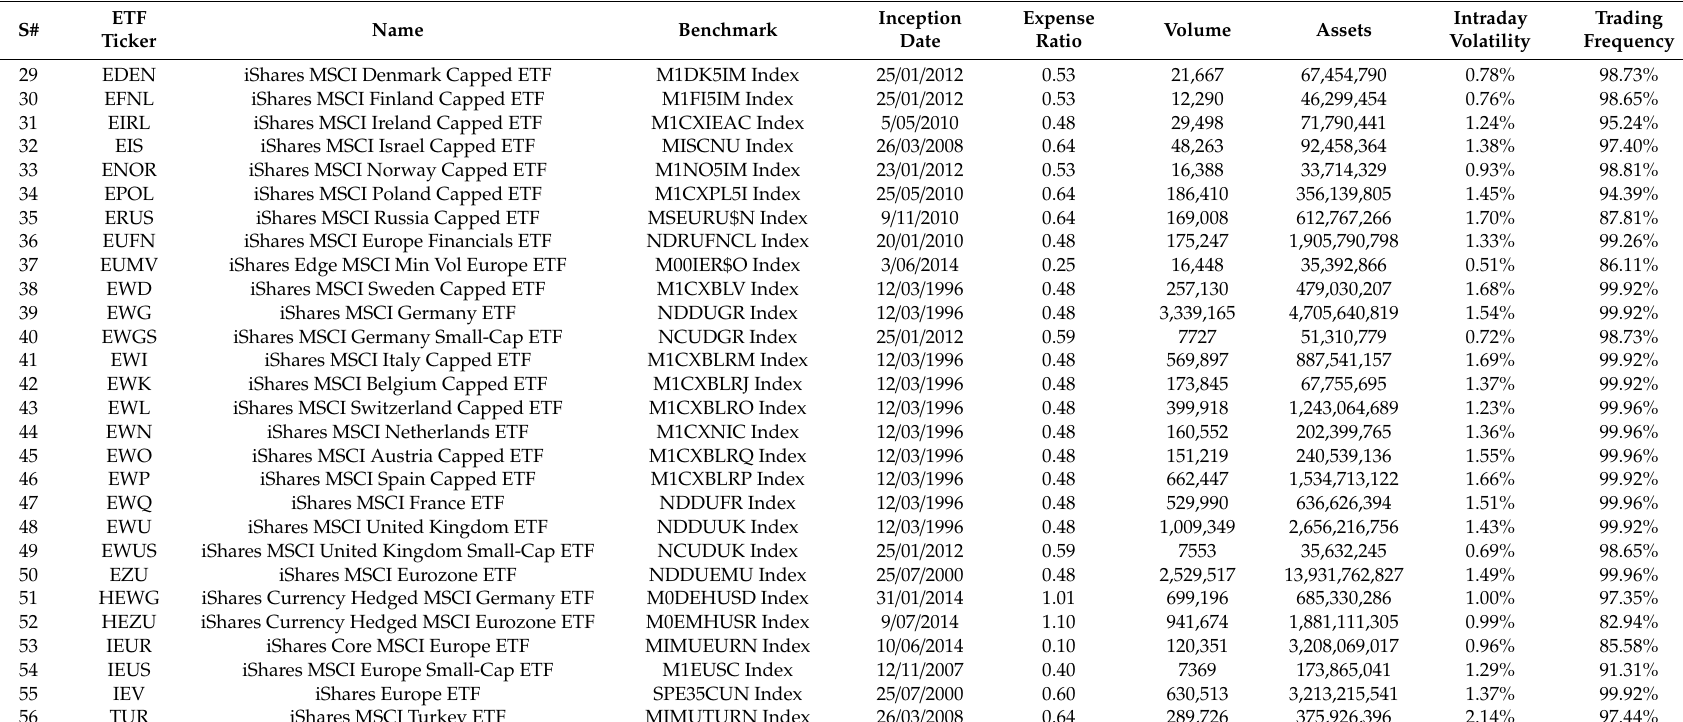
Table A2. Profiles of International ETFs tracking European